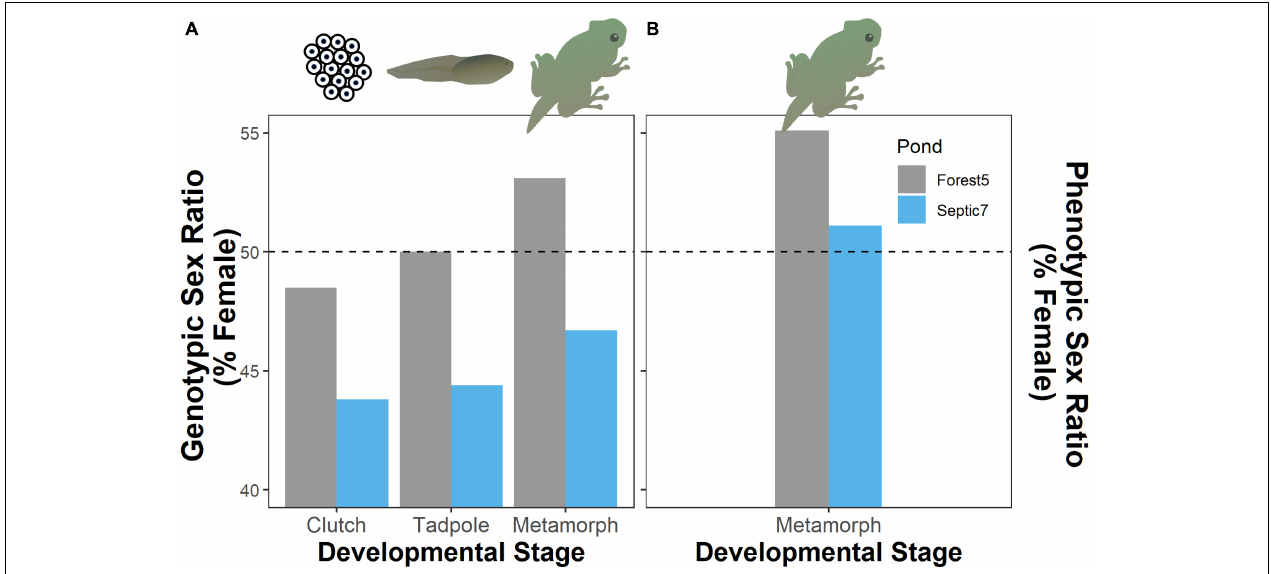
FIGURE 2 | Evidence for genotypic male-biased mortality as genotypic sex ratios (A) in both ponds (Forest5 and Septic7) become increasingly comprised of females as cohorts develop from clutches of embryos through the tadpole stage and into metamorphosis. Final phenotypic sex ratios in these cohorts (B) are comprised of more females than would be expected from genotypic sex ratios due to sex reversal in both cohorts (4 and 12.5% of genotypic males reversing in Forest5 and Septic7, respectively). The horizontal dashed line represents a hypothetical 50:50 sex ratio (phenotypic or